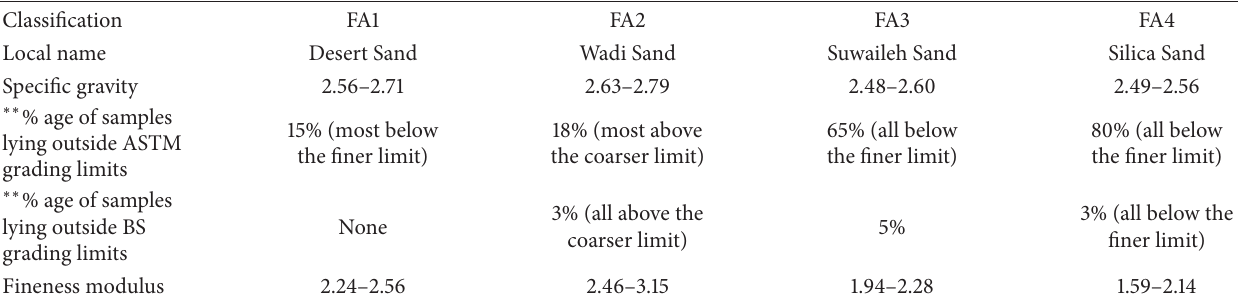
Table 2: Properties of fine aggregate used in the mix.